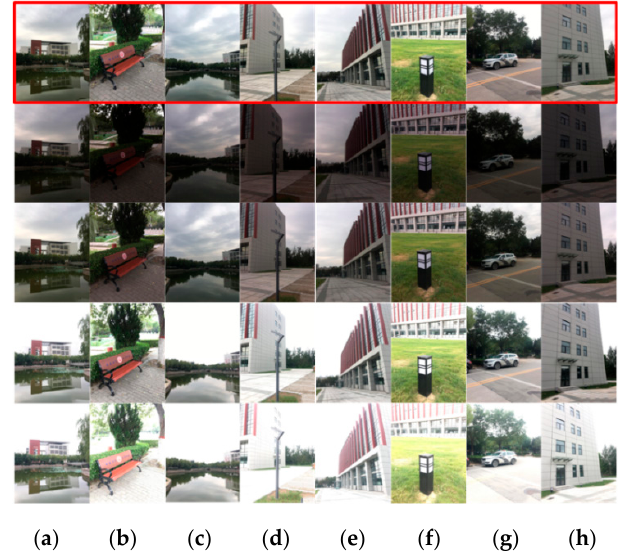
Figure 8. ( a )–( h ) are the sequences of a multi-exposure raw image. The top row is the selected reference image and the rest are the multi-exposure raw image